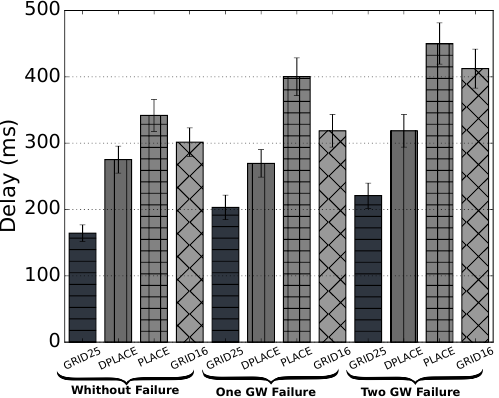
Figure 5. Mean delay for analyzed LoRaWAN gateway placement models.